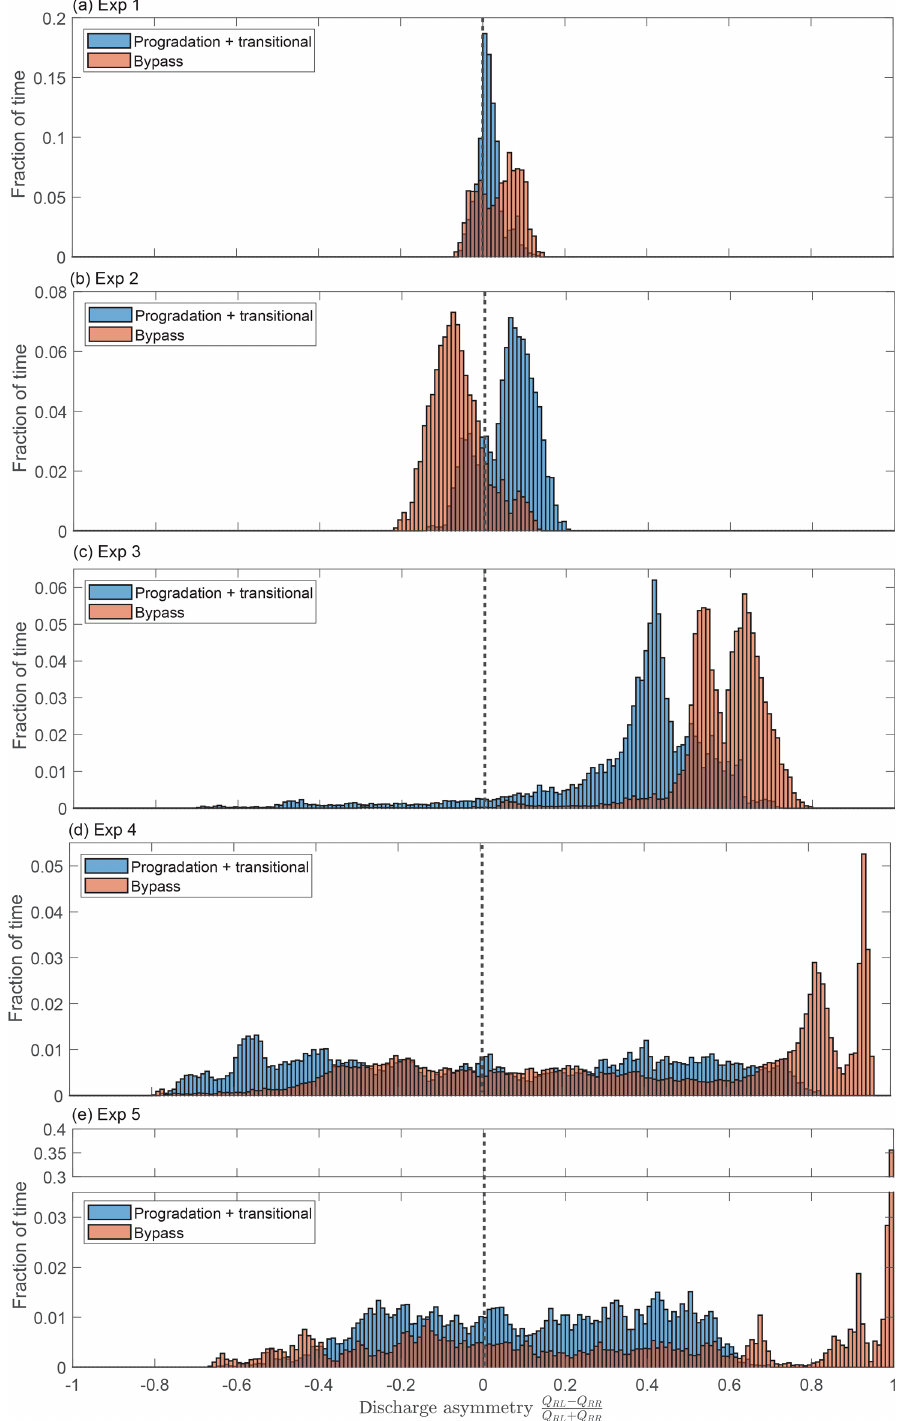
Figure 7. Histograms of the water discharge asymmetry from each experiment. Blue shows the progradation and transitional phases and orange shows the bypass phase. Negative values of the discharge asymmetry indicate that the river-right branch is capturing a greater proportion of the discharge, and vice versa for positive values. Note the break in y axis for panel (e) .